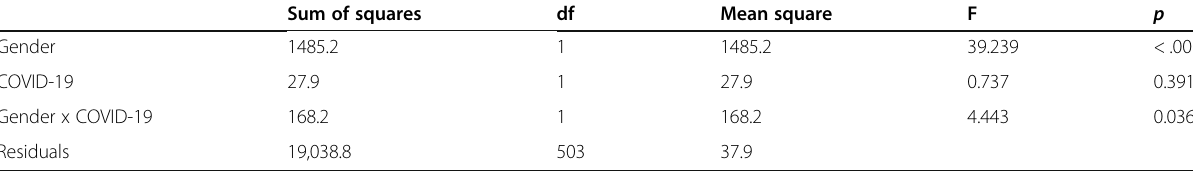
Table 4 Analysis of variance (ANOVA) of the effect of gender and COVID-19 infection on the scores of PHQ-9 Sum of squares df Mean square